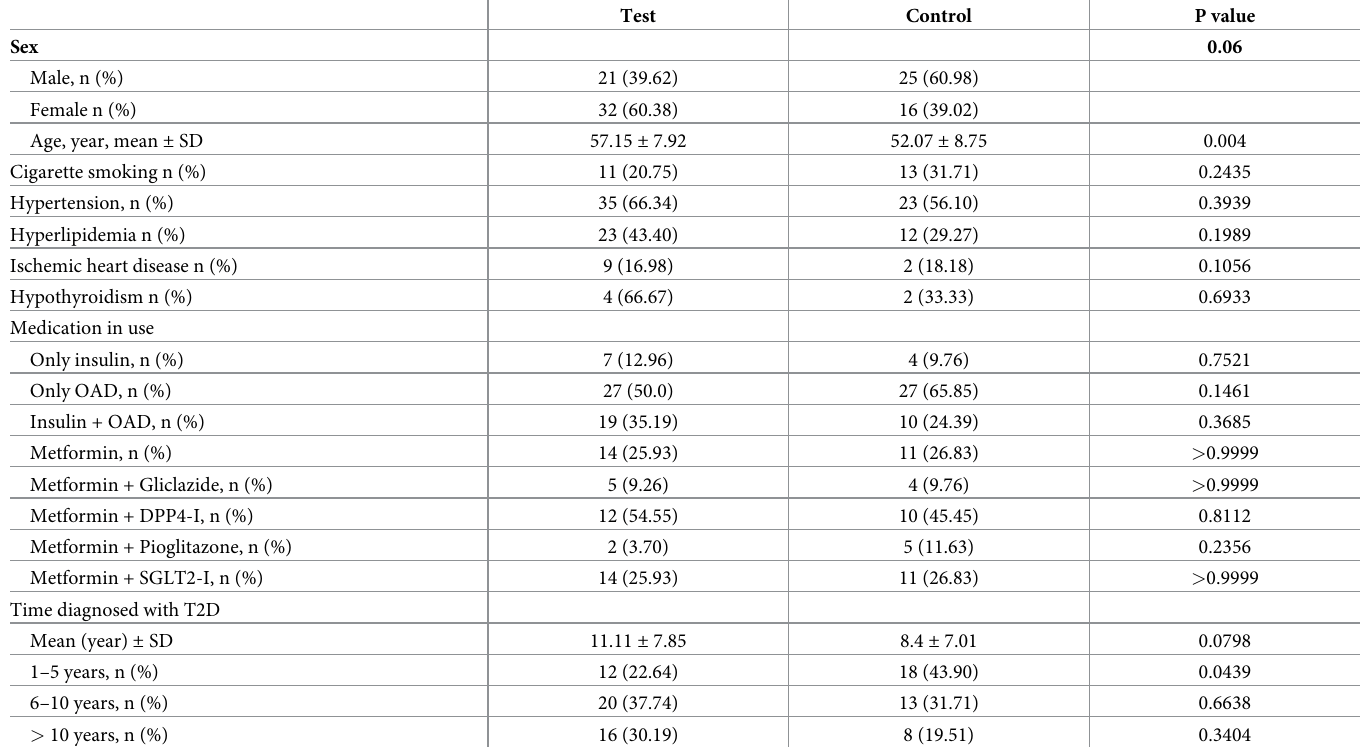
Table 1. Demographic, lifestyle, medication, and medical history of the subjects.